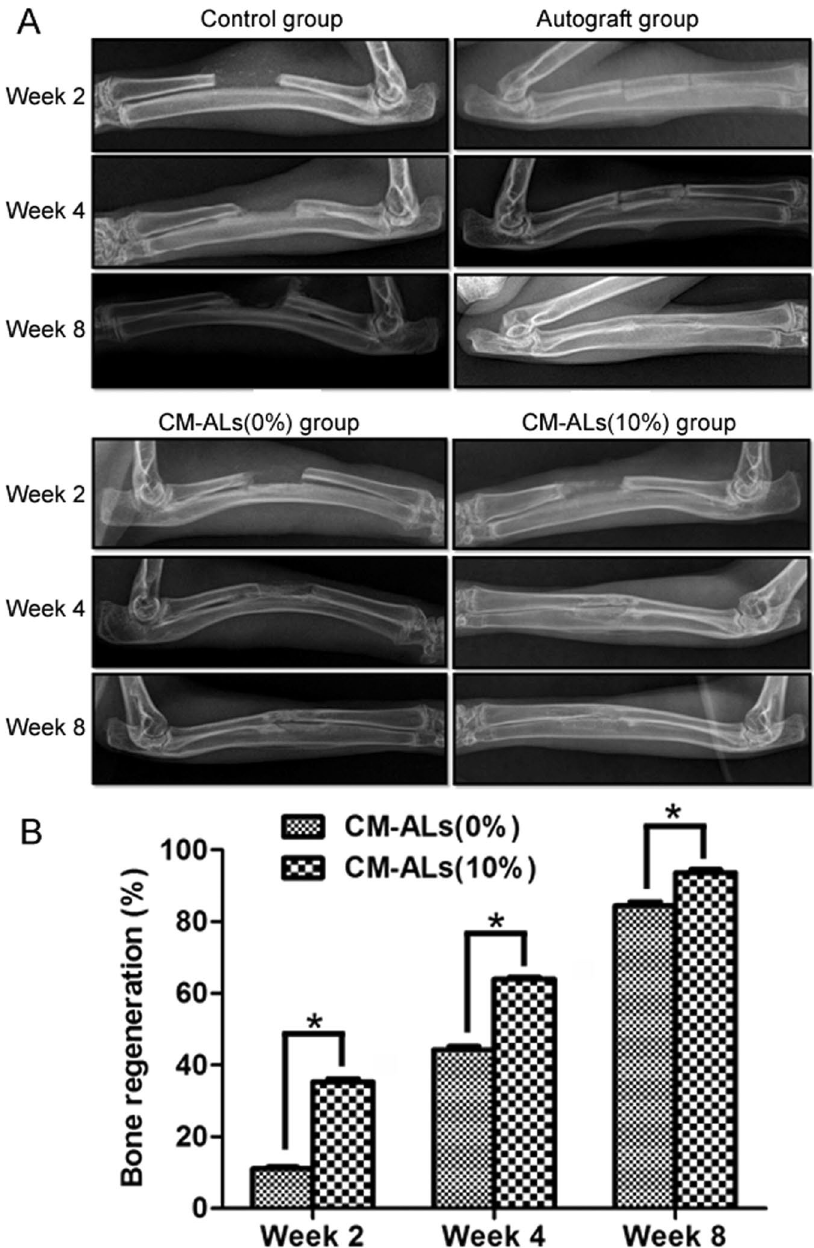
Figure 4. X-ray analysis of bone regeneration at different times after implanting operation. ( A ) Representative radiographs of bone regeneration at different times. In the control group, there was some new bone formation but the bone defect was not repaired; In autograft group, autologous orthotopic transplantation allowed a complete healing of radius defects during the 8 weeks follow-up; In CM-ALs (0%)-implanted group, there was obvious new bone formation at week 8. The bone fracture lines were scarcely observed, while bone marrow cavities were not found to become interconnected; In CM-ALs (10%)-implanted group, bone defects were healed with new bone formation during 4 to 8 weeks. ( B ) Semiquantitative analysis showed significant new bone formation in CM-ALs (10%)-implanted group when compared CM-ALs (0%)-implanted group and data increased with time. * p < 0.05 vs the CM-ALs (0%) control